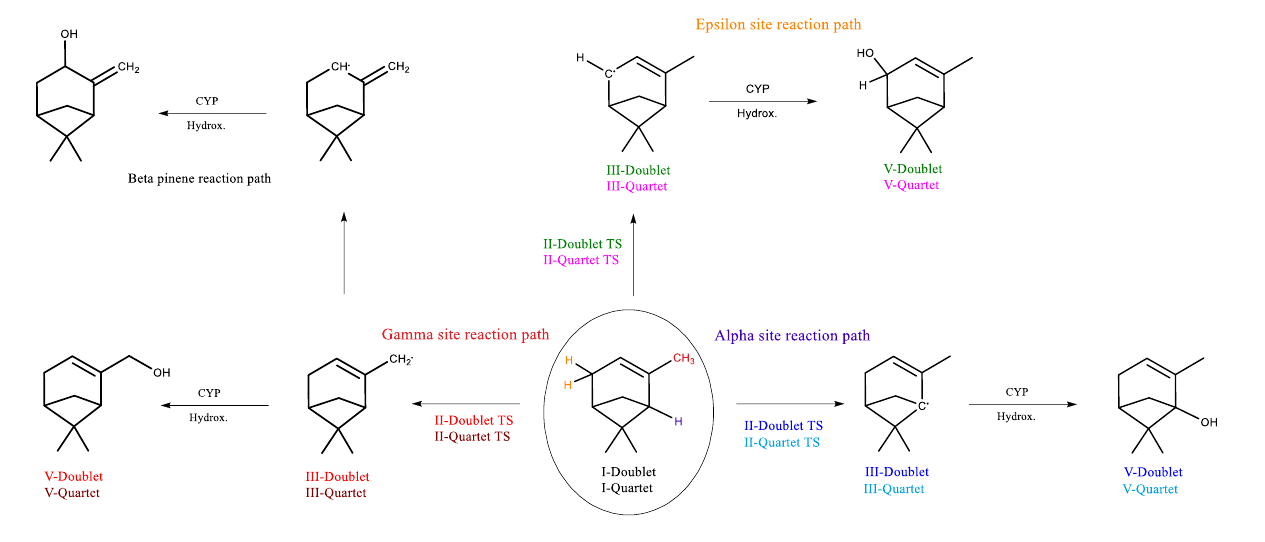
Figure 6. CYP- catalyzed hydroxylation of allylic sites of α -pinene. Figure 6. CYP-catalyzed hydroxylation of allylic sites of α -pinene.